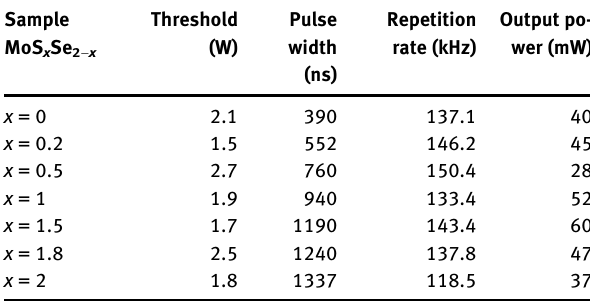
Table  : Saturable absorption parameters of  D MoS x Se  − x . nano- sheets based-SAs. Concentration